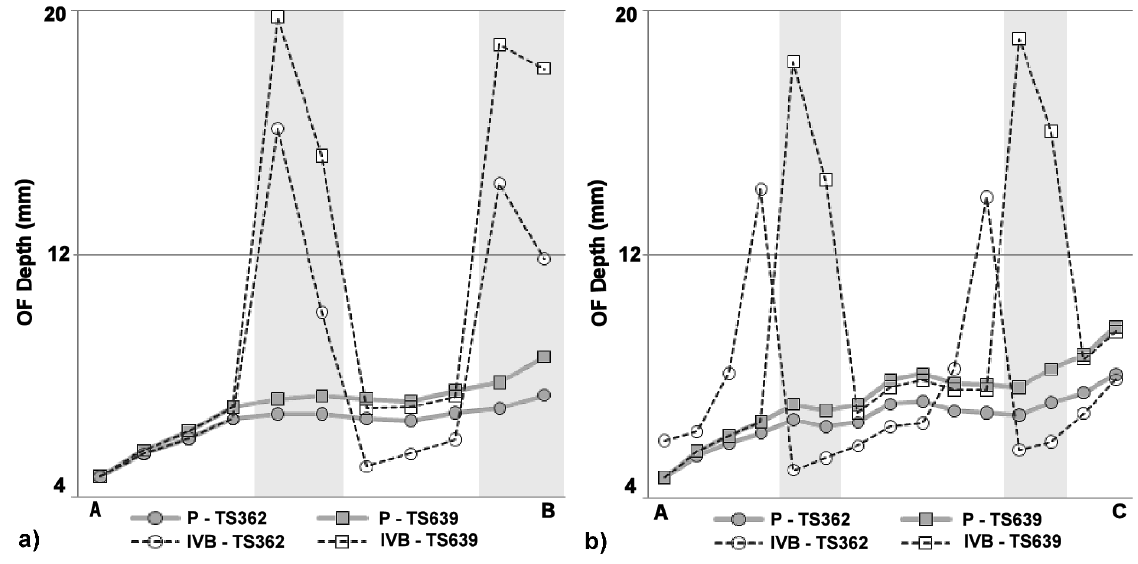
Figure 4. Two hillslope profiles showing overland flow ( OF) depth for two transects A-B ( a ) and A-C ( b ) at two time-steps (T362 and T639). The two transects start at a common cell (A) located on a central ridge of the sub-catchment (see Figure 2), with the trajectory of each at right angles down the steepest gradient to points B and C. TS362 was at the beginning of the first thunderstorm event when the soil was dry (12:15 PM 7 February 1999), whereas TS639 was taken when the catchment was saturated (4.15 PM 8 February 1999). The location of IVB along the transects are displayed as shaded